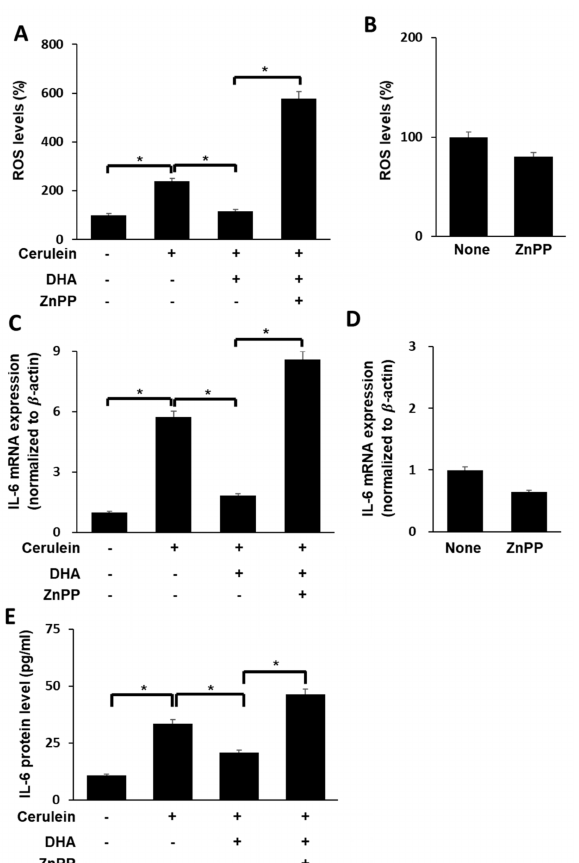
Figure 5. E ff ect of HO-1 inhibitor ZnPP on ROS levels and IL-6 expression in cerulein-stimulated DHA-treated AR42J cells. ( A ) Cells (2 × 10 5 / well) were treated with ZnPP (1 µ M) in the presence of DHA (50 µ M) for 1 h and stimulated with cerulein for 1 h. Then, cells were incubated with 10 µ g / mL DCF-DA for 30 min and washed with PBS. Cellular ROS levels were determined by measuring the level of fluorescent DCF. ( B ) Cells (2 × 10 5 / well) were treated with ZnPP alone (1 µ M) for 2 h. Then, cells were incubated with 10 µ g / mL DCF-DA for 30 min and washed with PBS. Cellular ROS levels were determined by measuring the level of fluorescent DCF. Intracellular ROS levels are expressed as the relative increase. The value for ROS levels in unstimulated cells (without cerulein stimulation) in the absence of DHA was set at 100%; ( C ) cells (2 × 10 5 / well) were treated with ZnPP (1 µ M) in the presence of DHA (50 µ M) for 1 h and stimulated with cerulein for 6 h. IL-6 mRNA expression was determined by real-time PCR analysis and normalized to β -actin mRNA expression. ( D ) Cells (2 × 10 5 / well) were treated with ZnPP alone (1 µ M) for 7 h. IL-6 mRNA expression was determined by real-time PCR analysis and normalized to β − actin mRNA expression. ( E ) Cells (2 × 10 5 / well) were treated with ZnPP (1 µ M) in the presence of DHA (50 µ M) for 1 h and stimulated with cerulein for 24 h. IL-6 concentration in the cell culture medium was determined using ELISA. Data are expressed as the mean ± S.E. of three independent experiments. * p < 0.05. + , with treatment; − , without